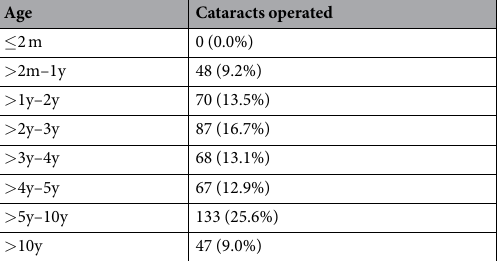
Table 1. Distribution of ages at surgery in congenital/developmental cataract patients. Values are presented as n and percentage of all the congenital/developmental patients reviewed in this study in the bracket. m = month; y = year.